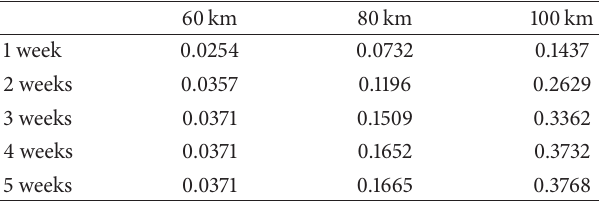
Table 5: Filtered AE as precursor from July 5, 2011 to September 5, 2011. Cumulative probability 𝐶 + ( r, 𝜏 ) for radius r ranging between 60 and 100 km, and time 𝜏 varying from 1 week to 9 weeks.